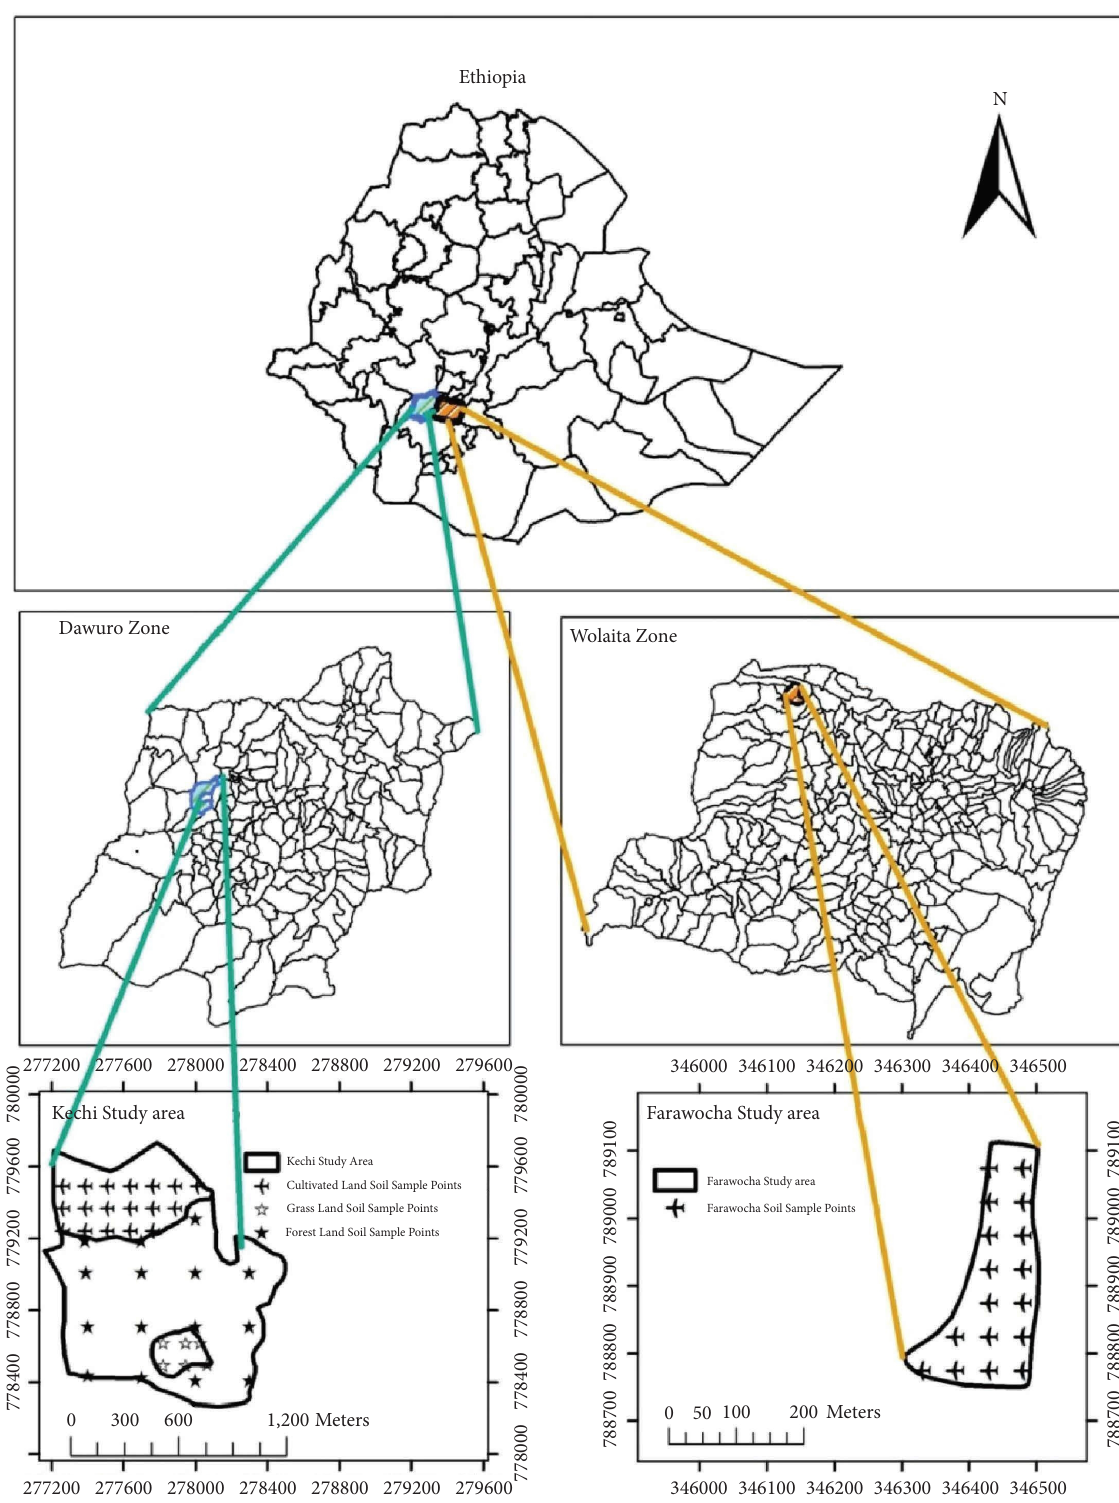
Figure 1: Location maps and soil sample collection points of both Farawocha and Kechi study